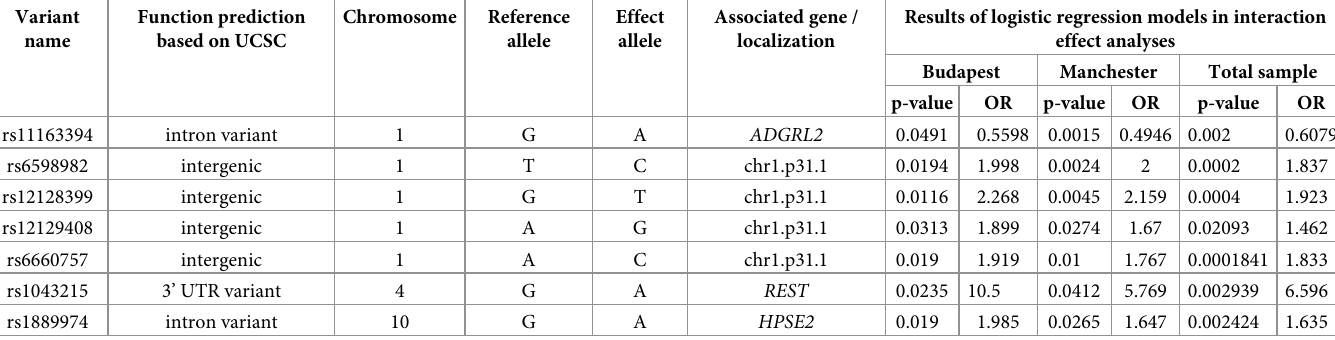
Table 2. Clumped results representing significant regions showing interaction with lifetime depression for migraine by logistic regression analysis.